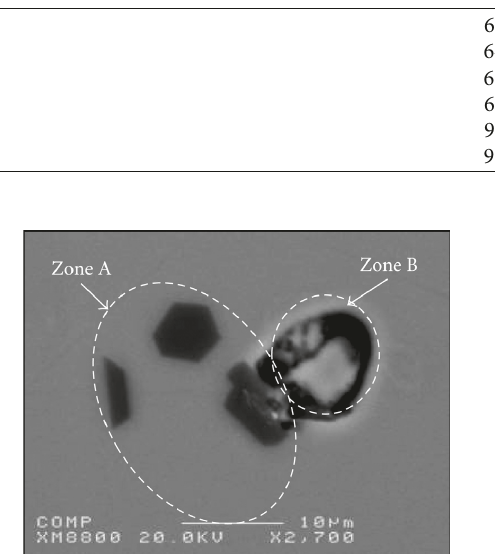
Figure 14: Presence of B and Si in Al-7%Si alloy treated with 800ppm B. Note the geometric shape of the particles in Zone A. Figure 13: (a) Presence of AlB 12 in ultrapure aluminum (possible decomposition of AlB 12 to AlB 2 ) and (b) X-ray image of B dis- tribution in AlB 12 phase particles in (a) (arrow).